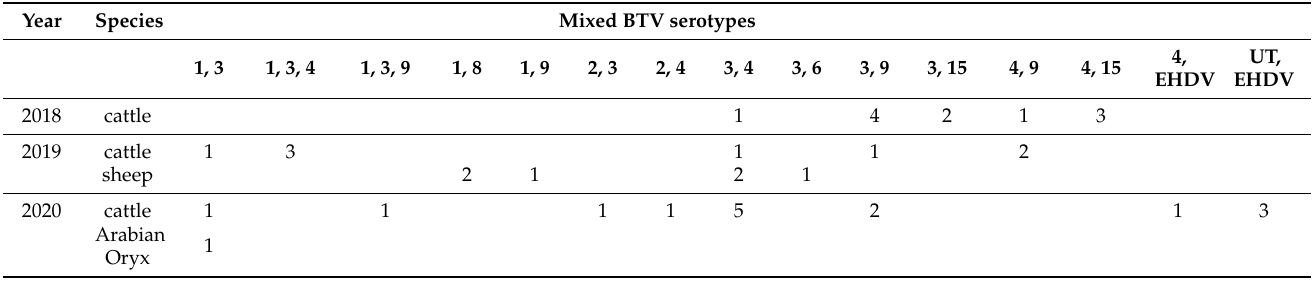
Table 3. Mixed BTV and EHDV-7 cases identified by serotype specific RT-qPCR or/and partial sequencing of segment 2 of isolated viruses during